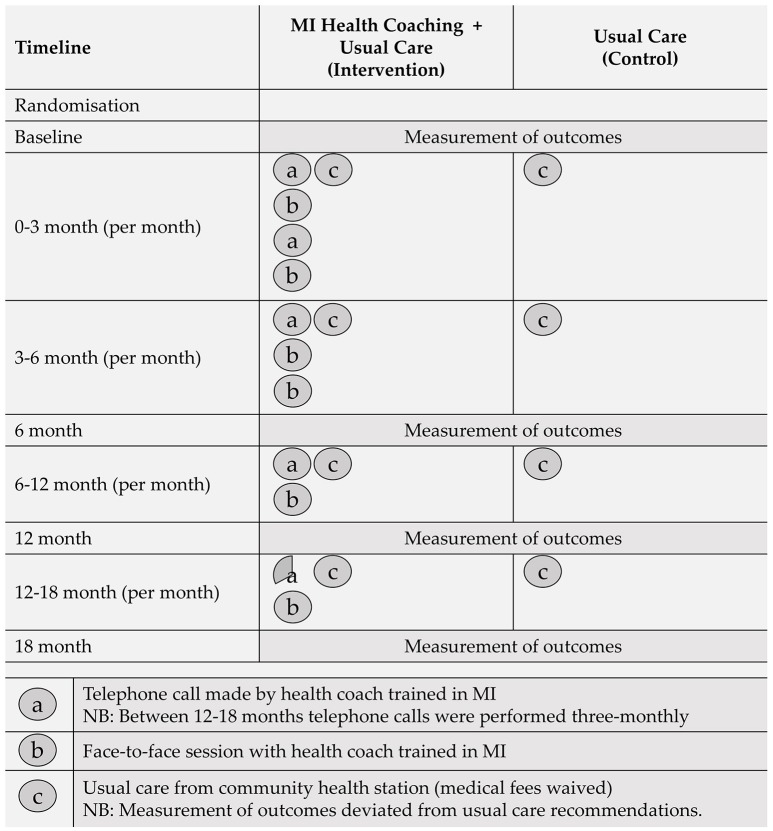
Graphical representation of interventions for each treatment condition.